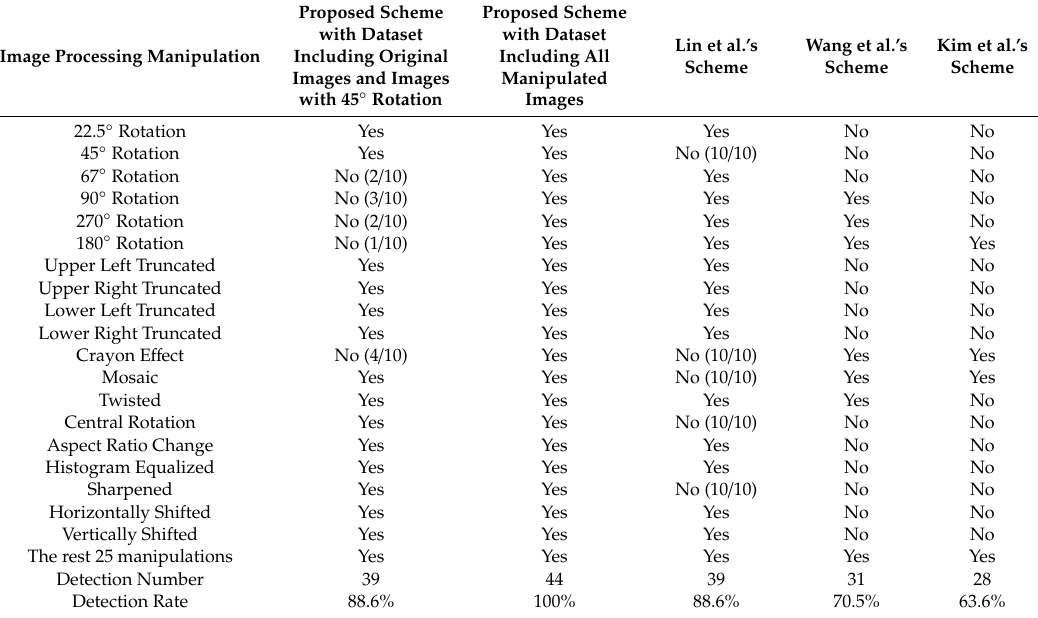
Table 5. Comparison I of the detection results in di ff erent image processing manipulations.